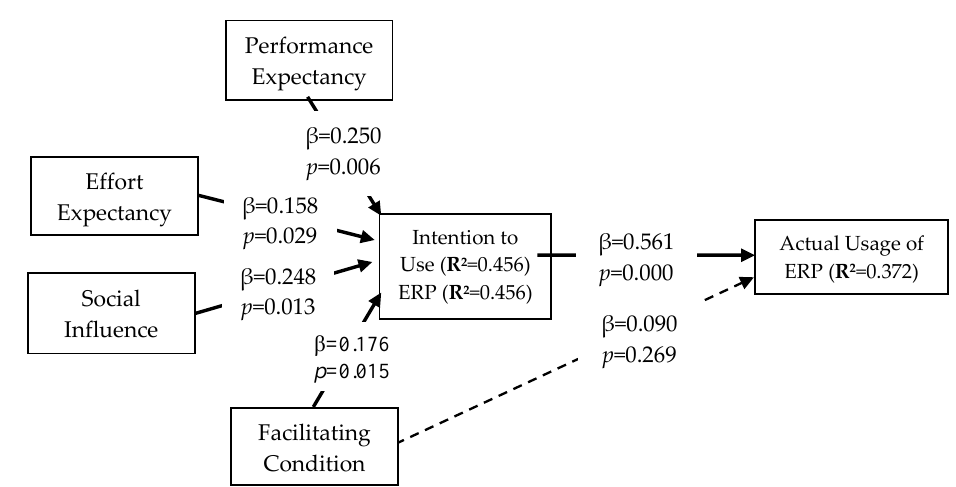
Figure 2. The PLS model along with path estimates.